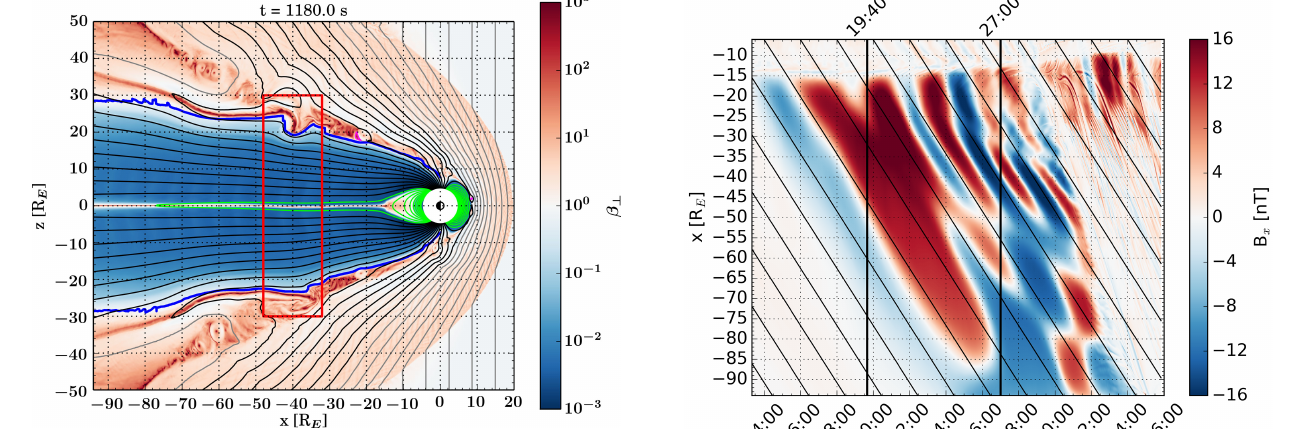
Figure 2. Earthward component of the magnetic field ( B x , color) at the nominal position of the tail current sheet ( y = z = 0) as a function of x and time (MM:SS, where MM indicates minutes and SS seconds). The tilted black lines indicate motion at the solar wind velocity V x = − 750kms − 1 . The vertical black lines at 19:40 and 27:00 mark the time of Fig. 1 and the onset time of tail reconnection at x ≈ − 14 R E ,